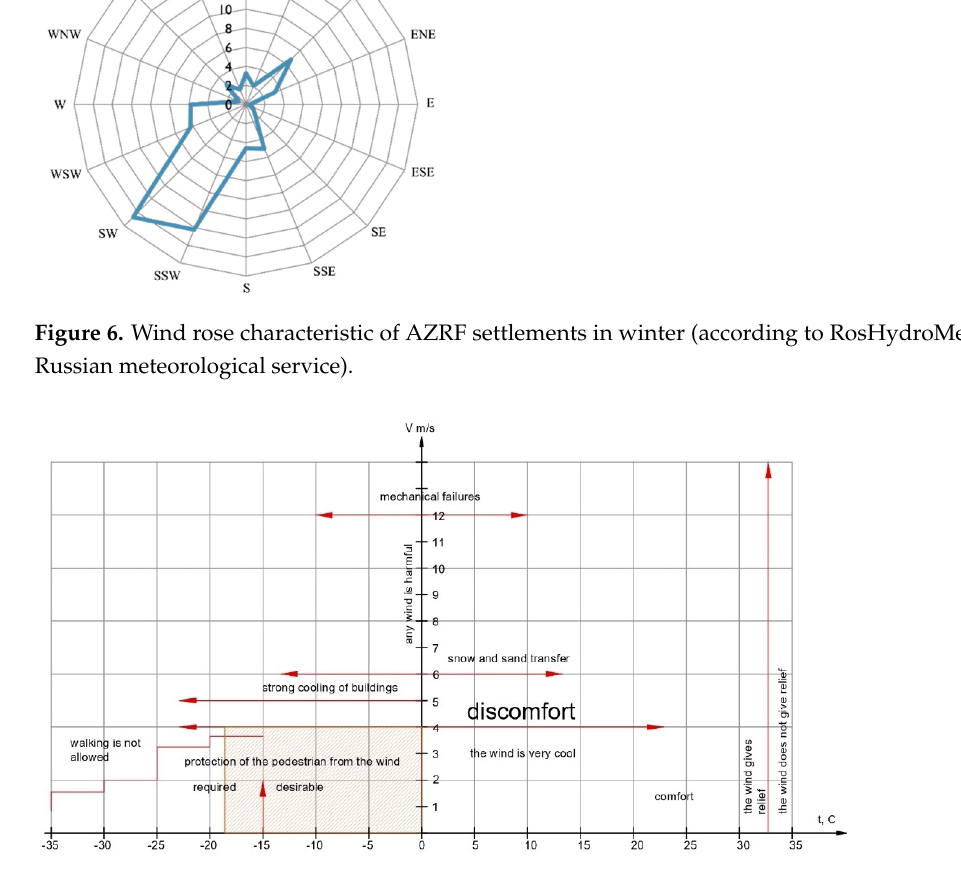
Figure 7. Determination of the boundary velocity for a theoretical study on the aeration regime in the residential development on sloping lands of the AZRF.